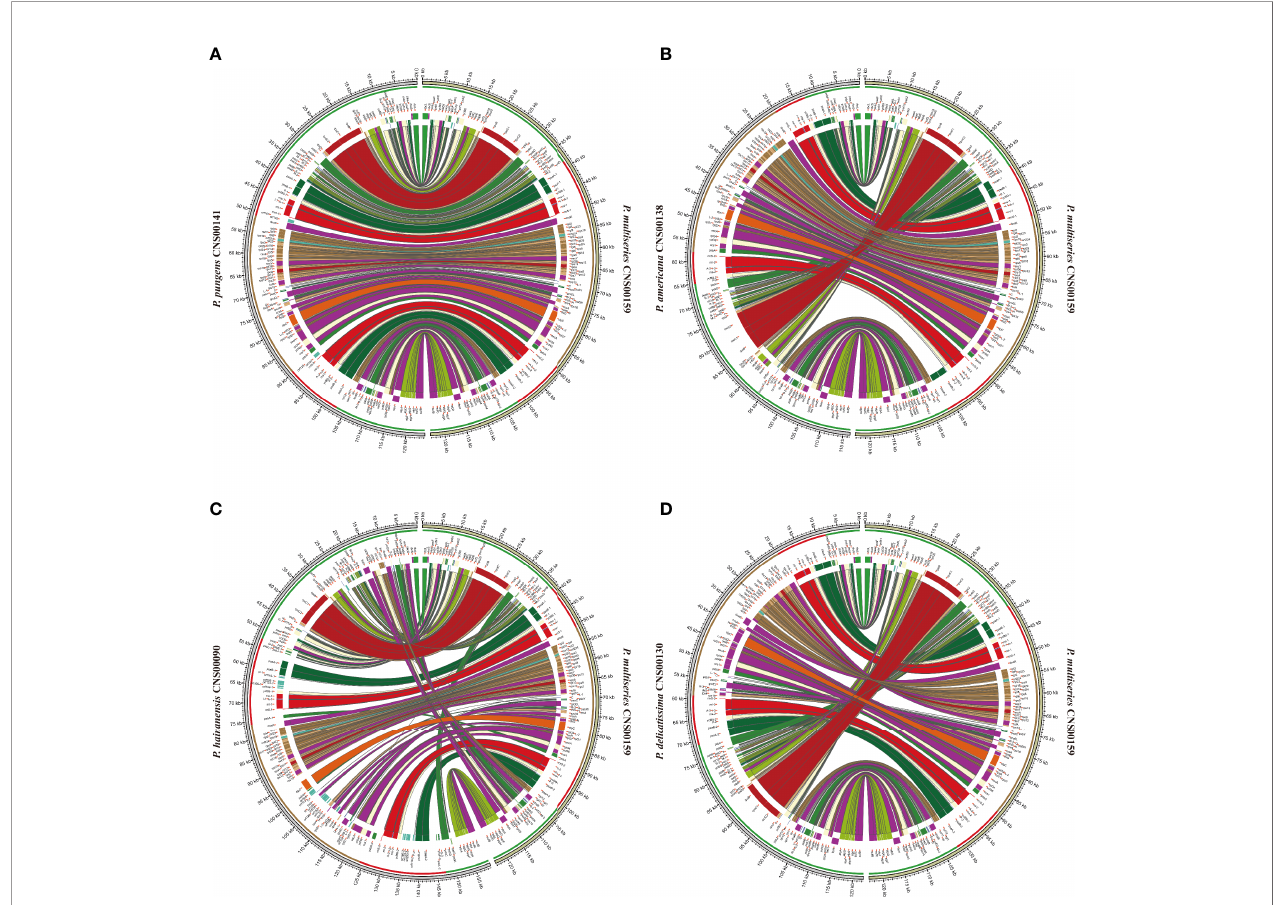
FIGURE 5 | The comparative analysis of cpDNAs of P. multiseries CNS00159 and 4 respective Pseudo-nitzschia species, including P. pungens CNS00141 (A) , P. americana CNS00138 (B) , P. hainanensis CNS00090 (C) , P. delicatissima CNS00130 (D)